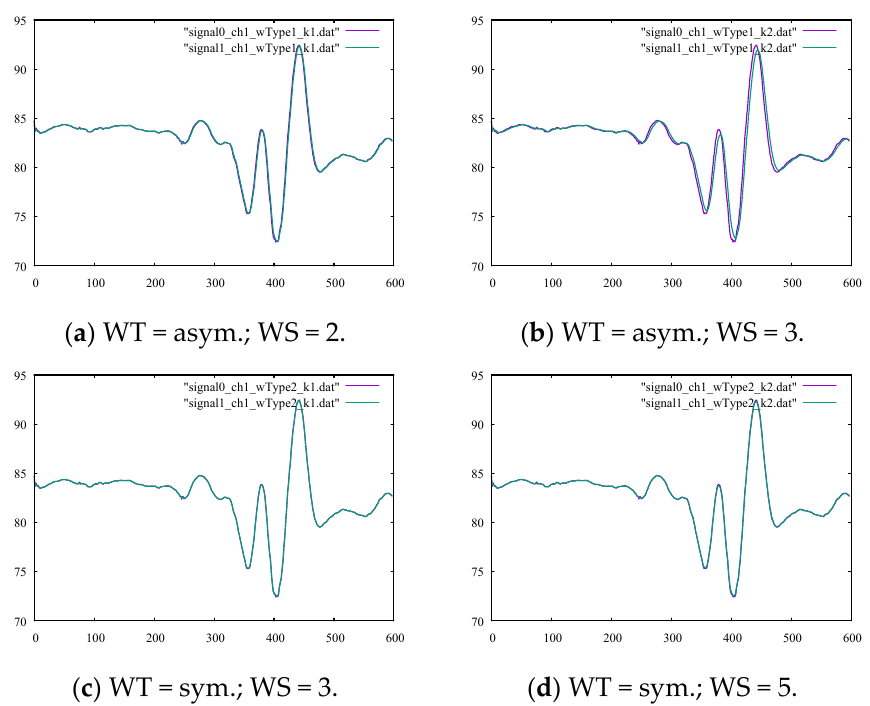
Figure 5. Original noisy motion signal from channel 1 of the root-joint of the kicking character versus the smoothed signal via the moving average filter using ( a ) an asymmetric window of size 2, ( b ) an asymmetric window of size 3, ( c ) a symmetric window of size 3, and ( d ) a symmetric window of size 5.